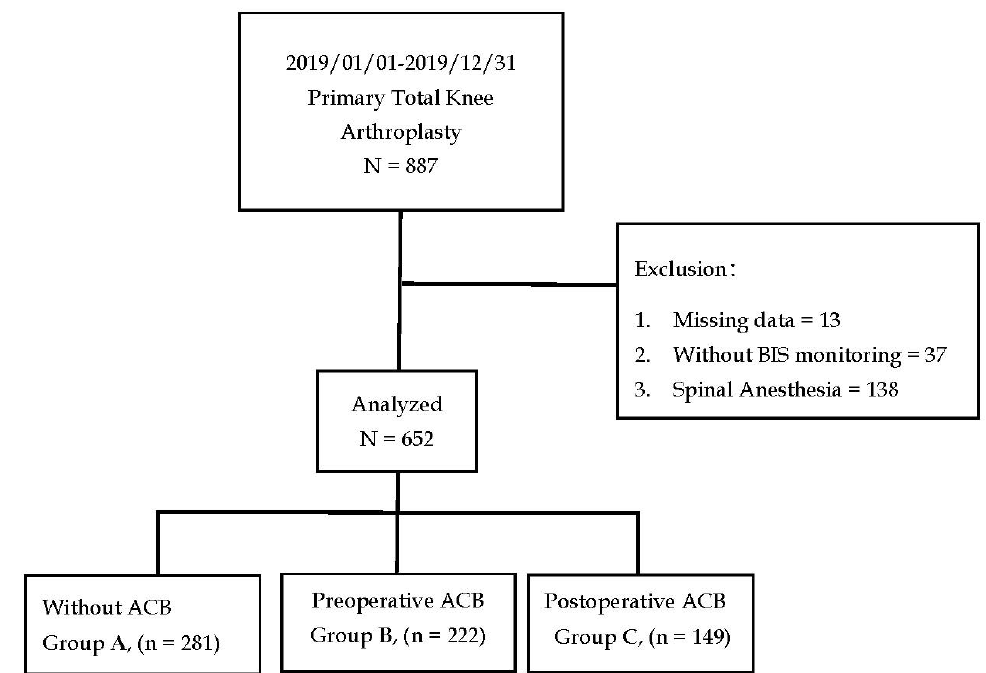
Figure 1. Flow chart of the allocation of patients who underwent primary total knee arthroplasty into Group A (non-ACB), Group B (preoperative ACB), and Group C (postoperative ACB).